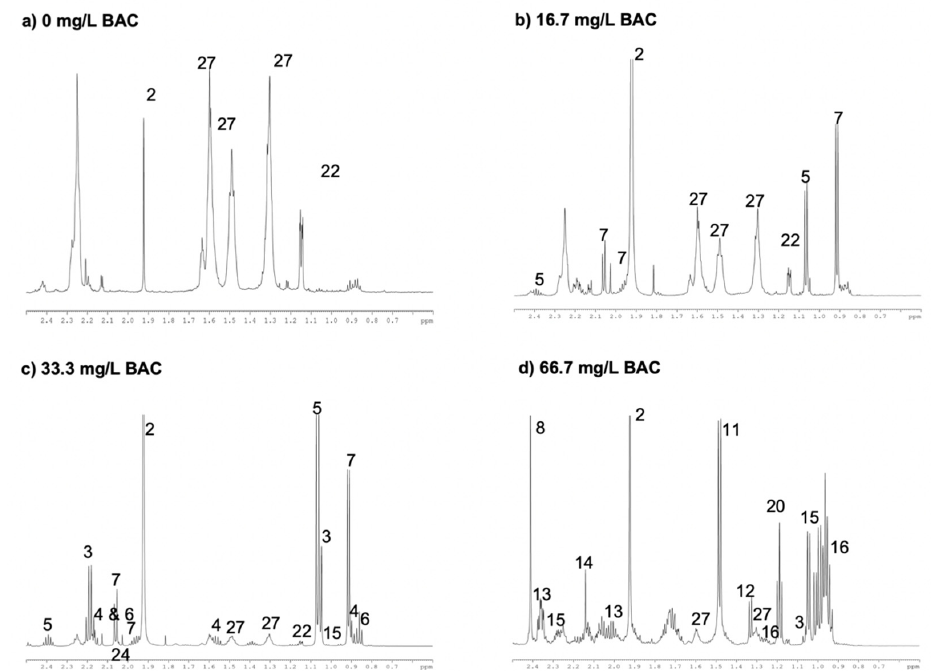
Figure 2. The alkyl region of the 1 H NMR spectra microcosm samples after 18 days of BAC exposure for ( a ) 0 mg/L BAC, ( b ) 16.7 mg/L BAC, ( c ) 33.3 mg/L BAC, and ( d ) 66.7 mg/L BAC. Peaks for confirmed structures are numbered and are identified in Table 1.